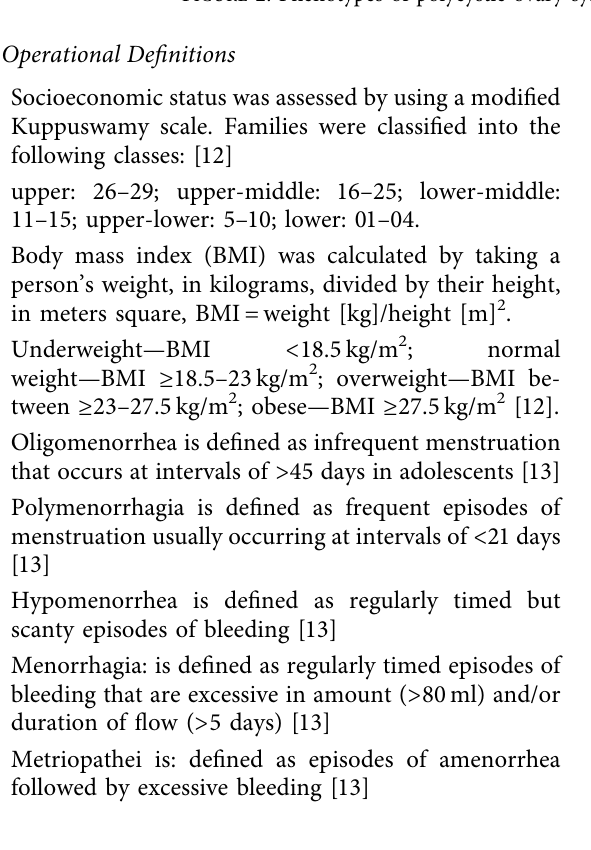
Figure 2: Phenotypes of polycystic ovary syndrome as per the Rotterdam criteria [11].